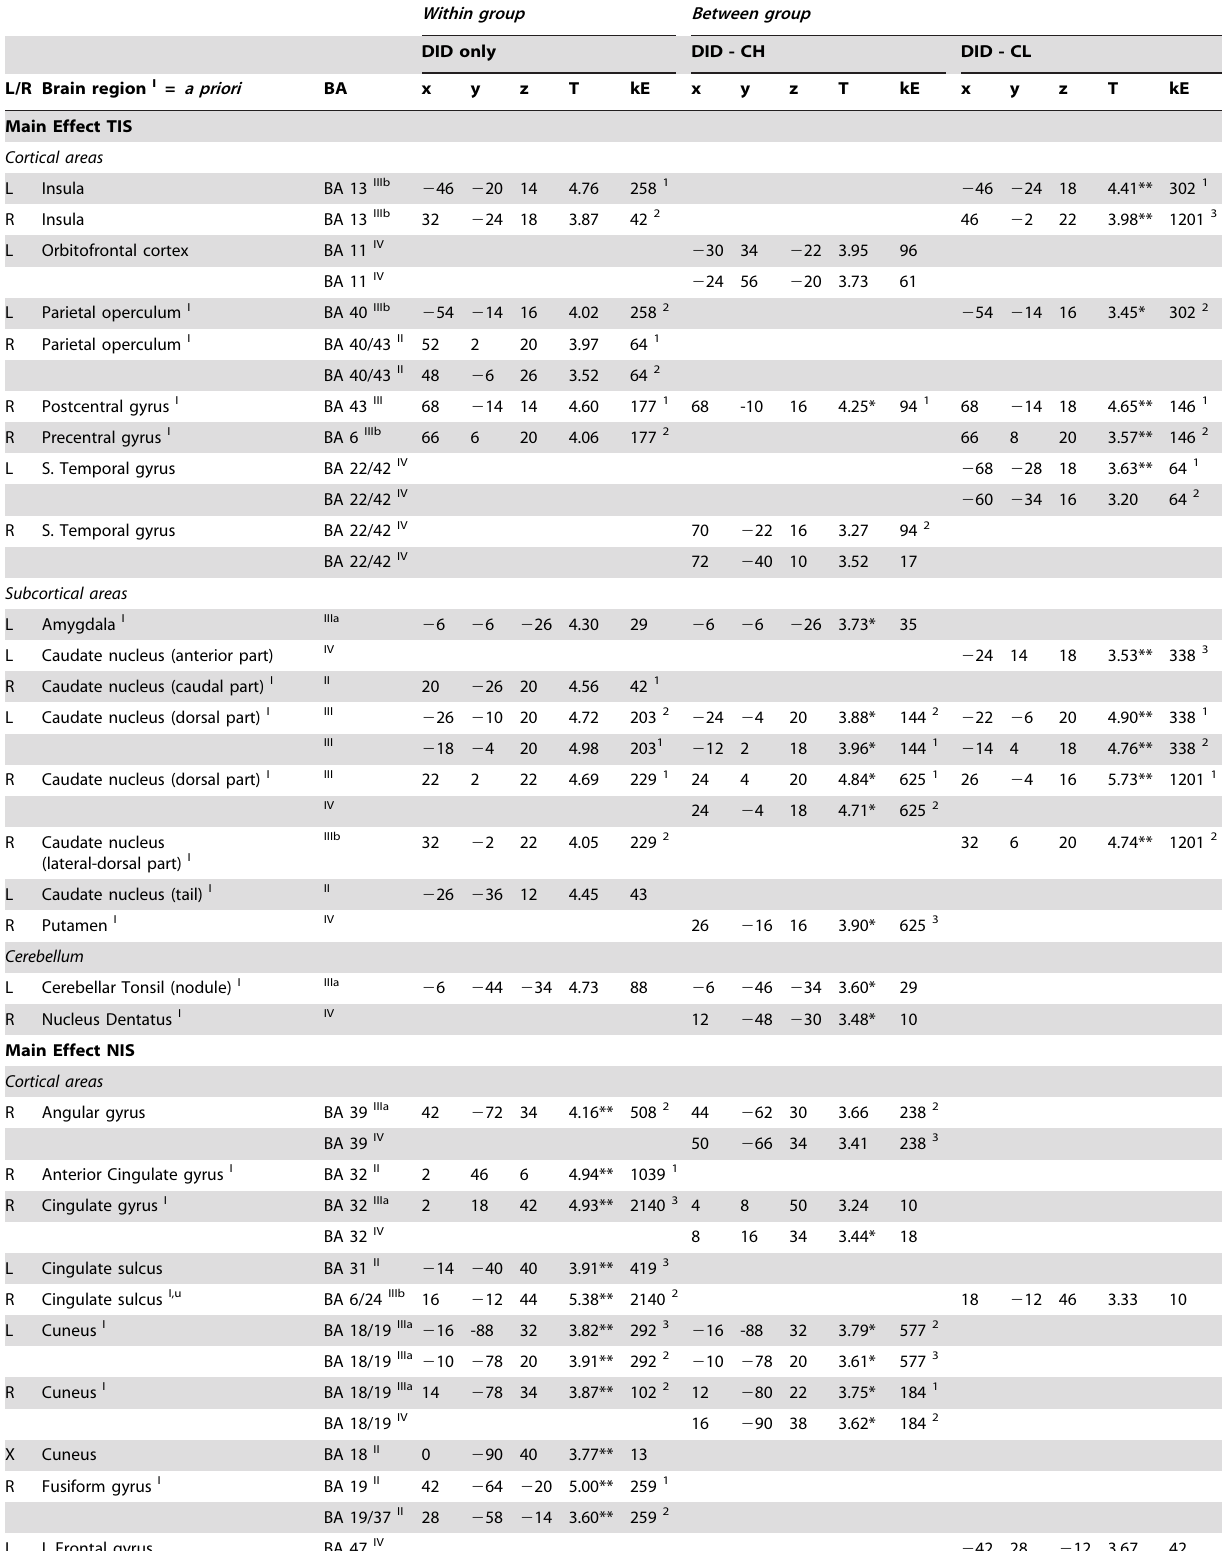
Table 2. Main effects.